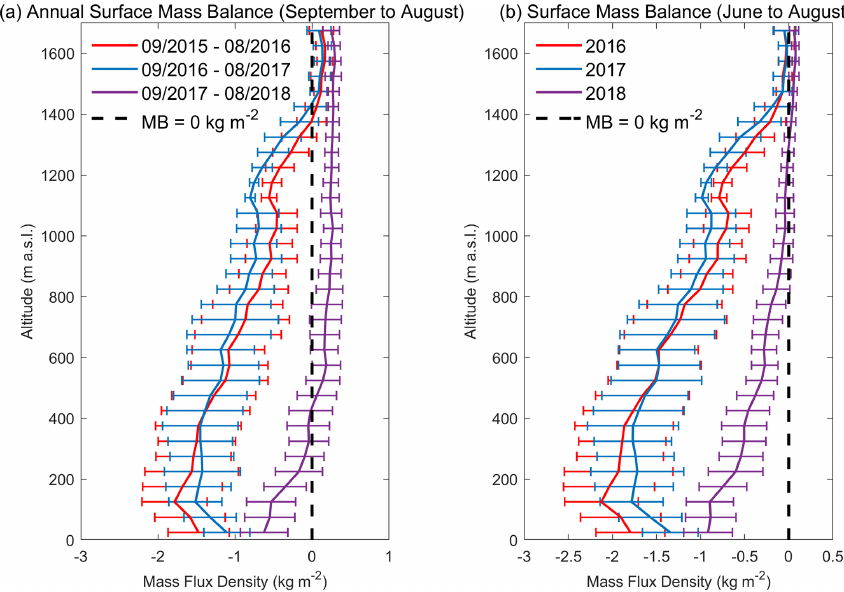
Figure 10. The annual (a) and summer (JJA) surface mass balance between September 2015 and August 2018, averaged over each altitude in 50m bands. Error bars indicate the standard deviation of SMB for each grid in the respective altitude